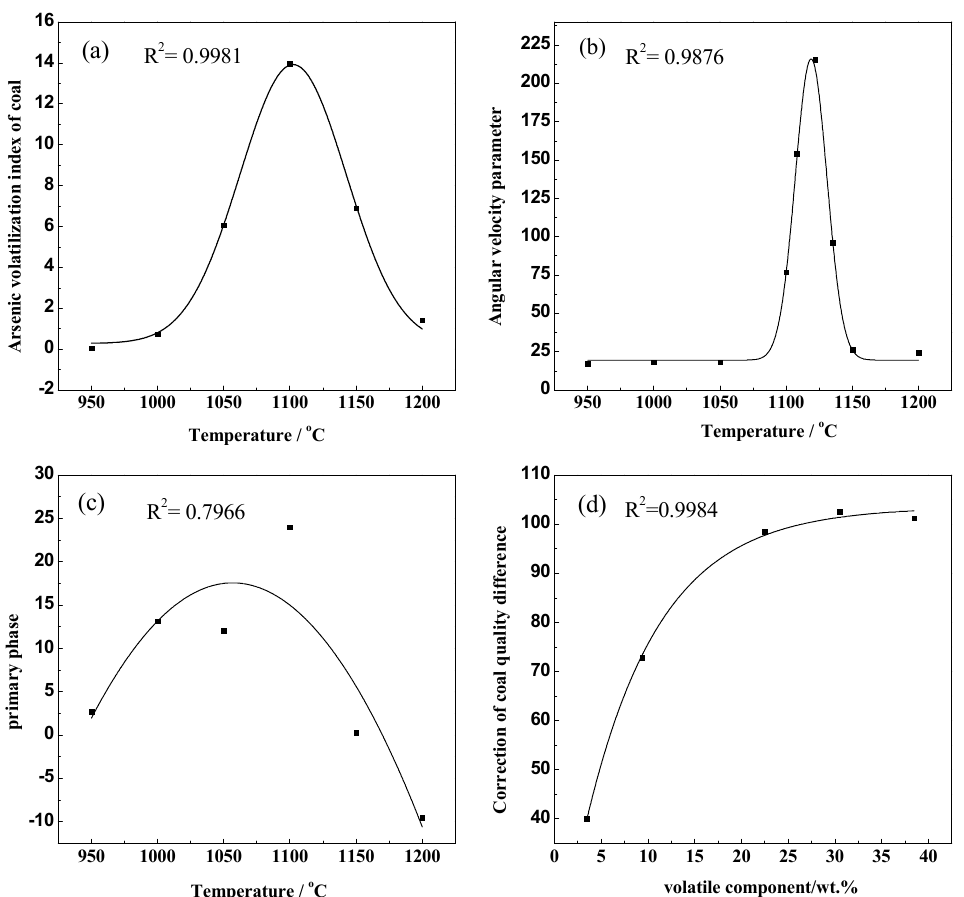
Figure 6. Functional relationship of parameters in the model. ( a ) Arsenic volatilization index versus temperature, ( b ) Angu- lar velocity parameter versus temperature, ( c ) Primary phase versus temperature, ( d ) coal quality difference versus volatile matter